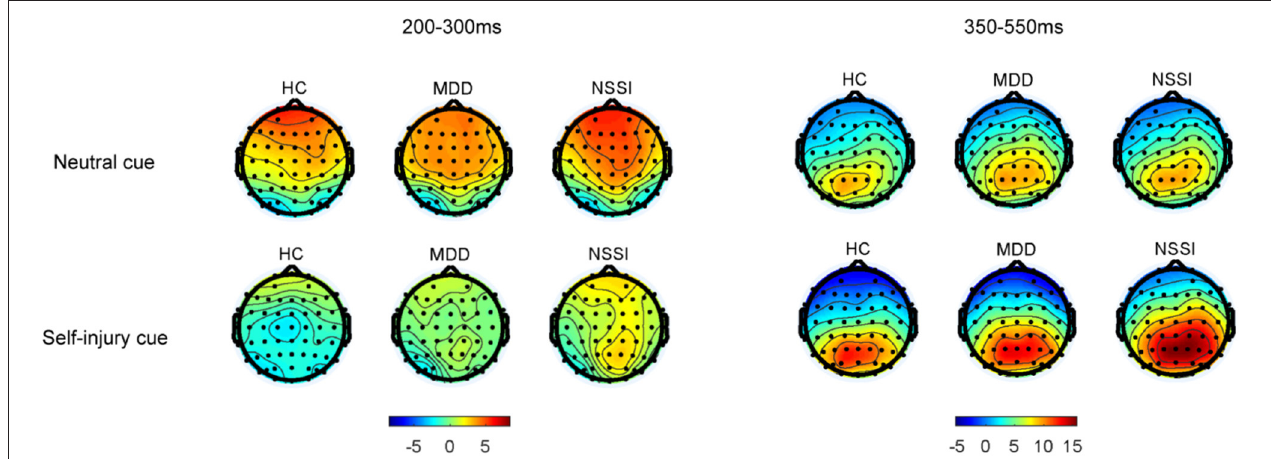
FIGURE 3 | Grand-average topographic maps of the N2d (200–300ms) and P3d